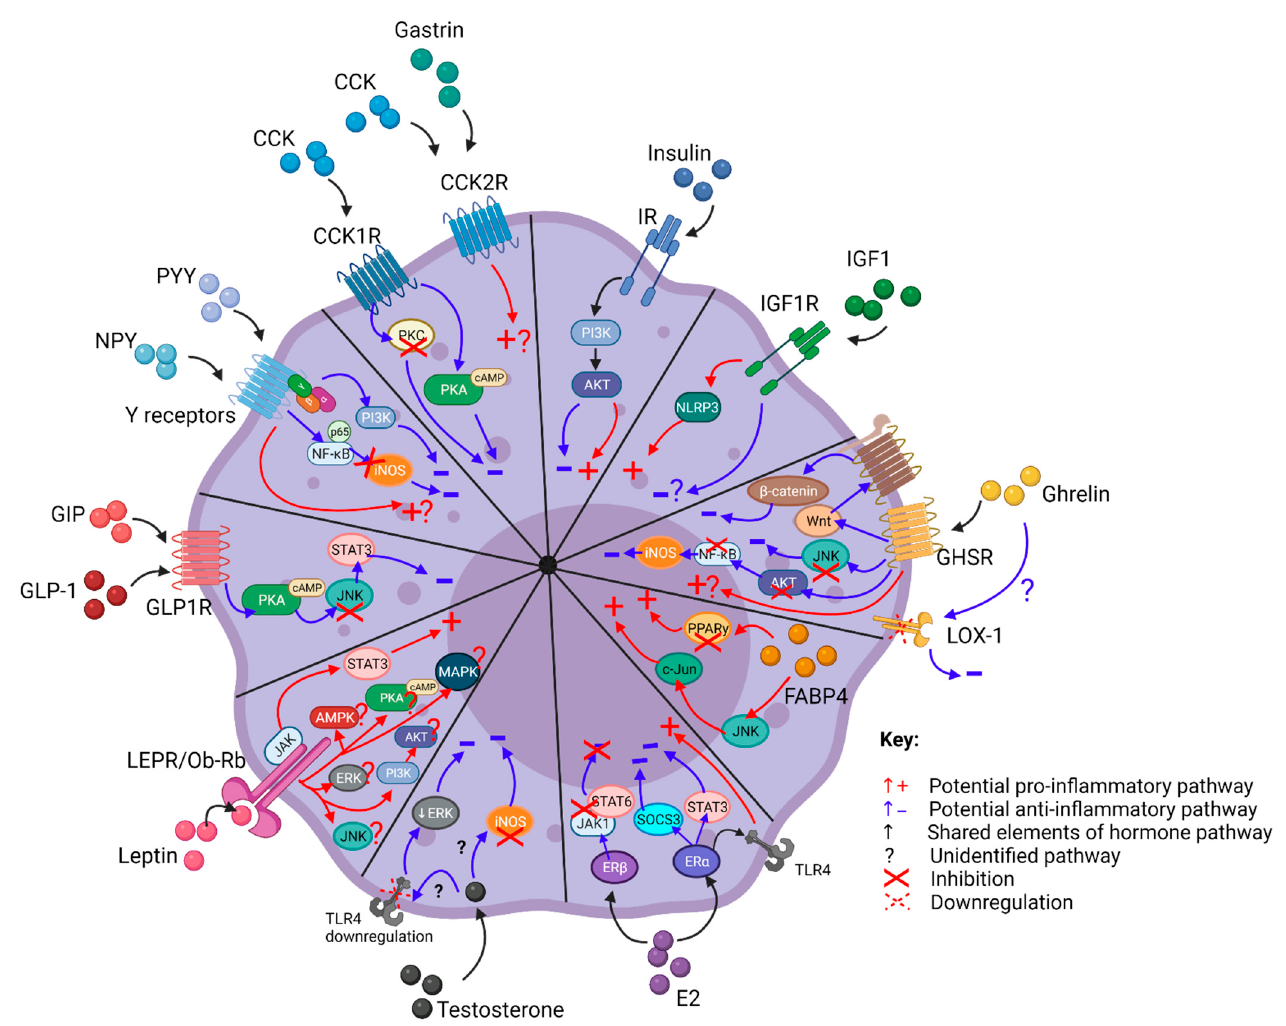
Figure 3. Schematic summarising the potential intracellular signalling mechanisms by which metabolic hormones affect macrophage inflammatory responses. This figure was created with Biorender.com.